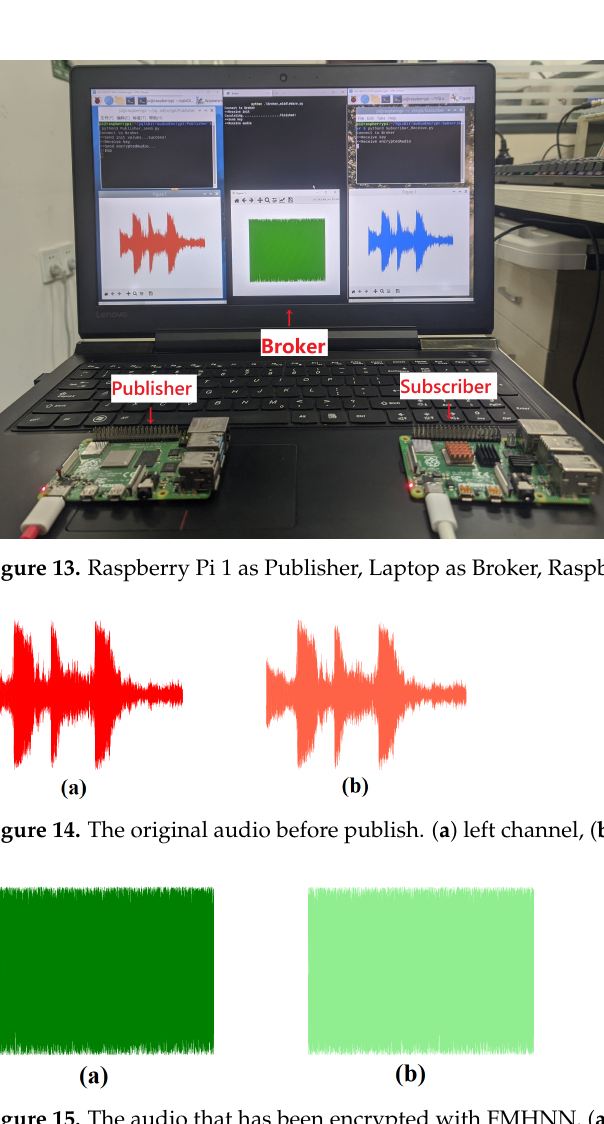
Figure 15. The audio that has been encrypted with FMHNN. ( a ) left channel, ( b ) right channel.